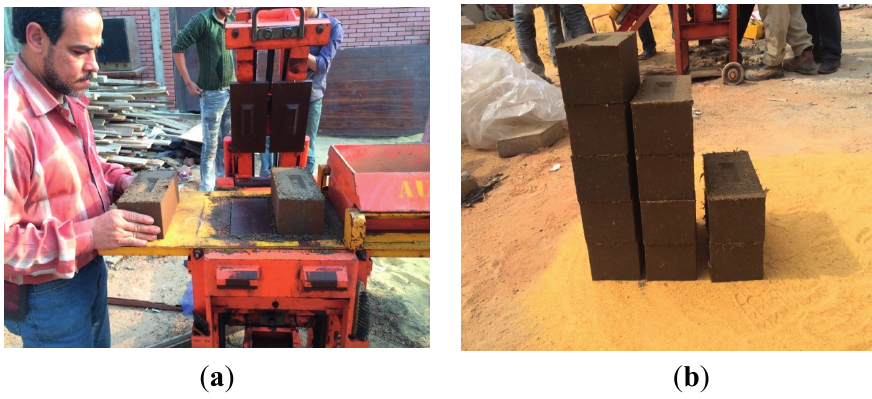
Figure 4. ( a ) Ejecting the Green-Compressed Earth Block (GCEB) from the mold; ( b ) Placing the blocks